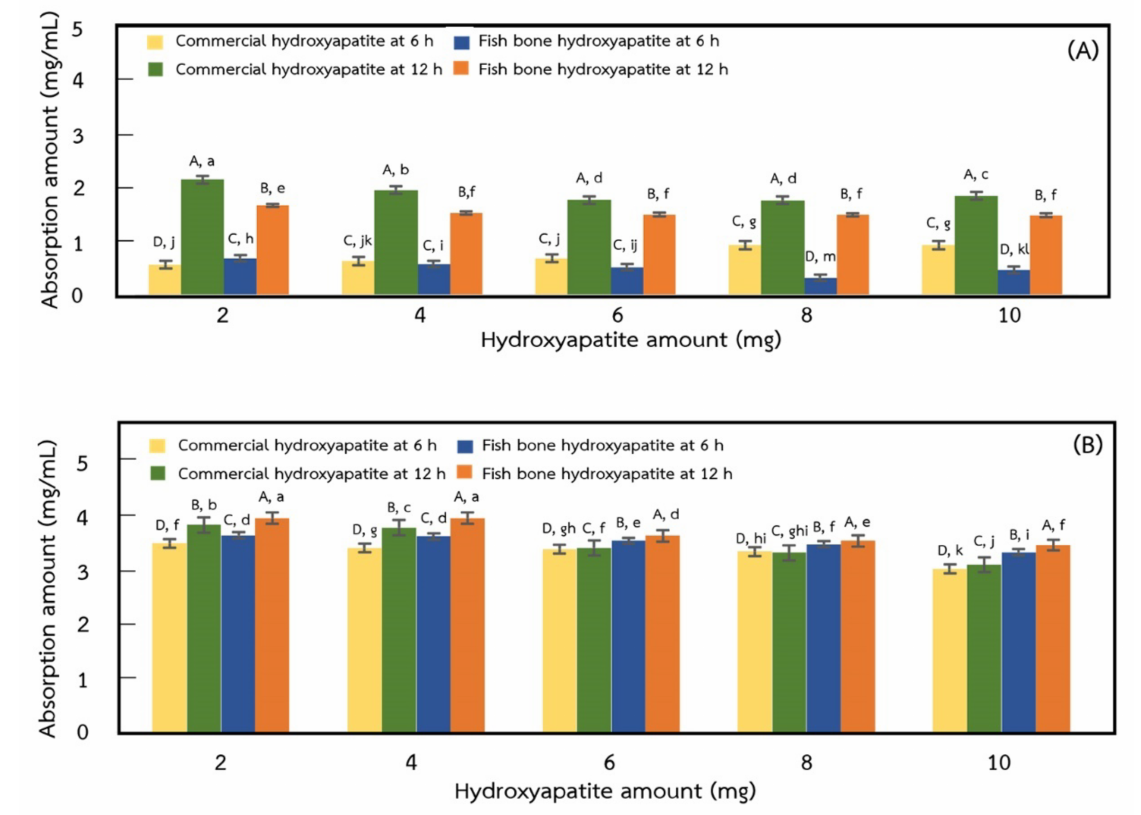
Figure 7. BSA adsorption onto commercial and extracted hydroxyapatites using BSA solutions at concentration of 0.5 mg/mL ( A ) and 1.0 mg/mL for 6 h and 12 h ( B ). Different upper-case letters in same amount of hydroxyapatite indicate significantly differences ( p ≤ 0.05) and different lower-case letters in all amount of hydroxyapatite indicate significantly differences ( p ≤